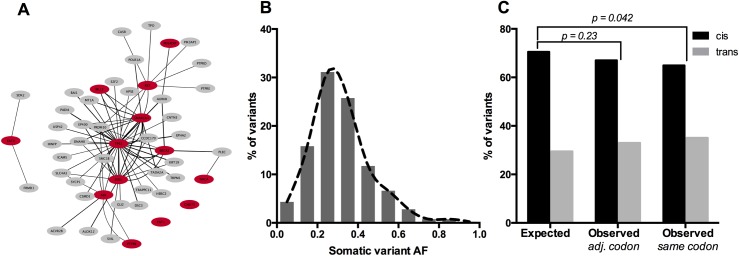
Cancer genes are affected by co-occurrence events but co-occurrence events do not exhibit positive selection signals.(A) COSMIC cancer genes affected by co-occurrence events and their affected network partners. Interactions were defined as having medium confidence or higher in STRING v.10.0, and were visualized in Cytoscape. (B) Variant allele fractions of all somatic variants involved in co-occurrence events with the germline. (C) Ratio of somatic variants found to be in cis versus in trans with germline variants. The expected ratio was derived from the allelic fractions of all germline variants in each cohort. Observed ratios were calculated for somatic variants that were candidates for affecting the same codon as a germline variant (same codon), and for somatic variants that were 1–2 nts away from a germline variant but predicted to affect a different codon (adj. codon).